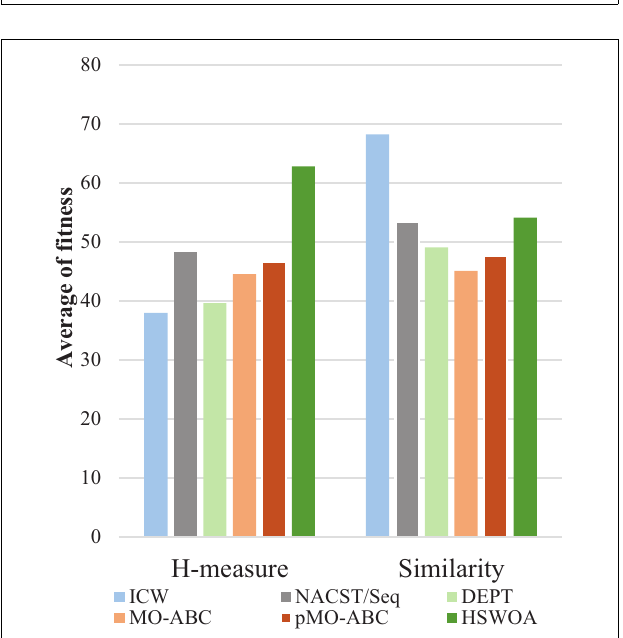
FIGURE 7 | Average fitness of H-measure and similarity for ICW and other algorithms.